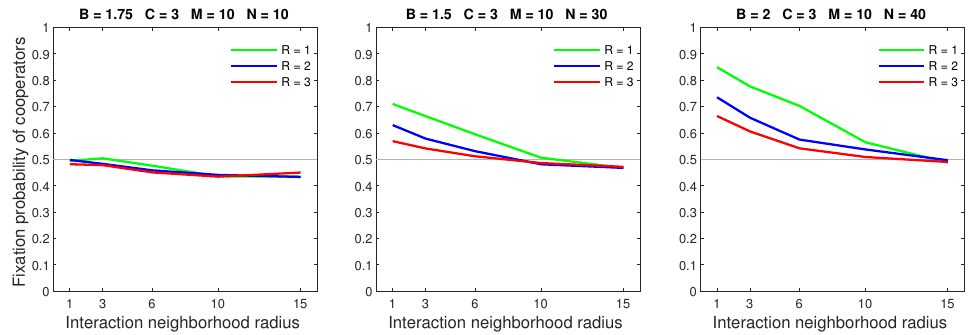
Figure 12. In the almost deterministic dispersal model, increasing the dispersal range for a high mobility rate ( M = 10) affects cooperators in dense populations, while sparse populations remain unchanged.